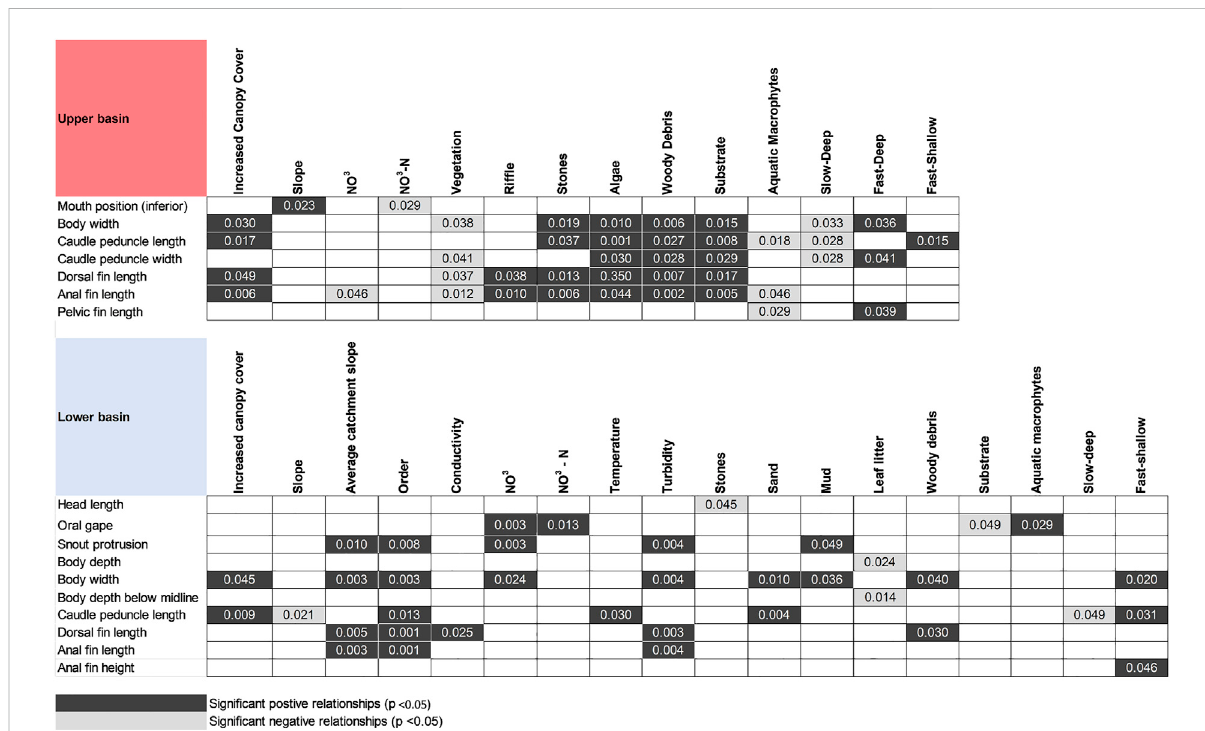
FIGURE 7 Results of the fourth-corner analyses for the upper and lower basin dataset. Black signi fi es a signi fi cant positive relationship (Pearson ’ s correlation) between environmental variable and trait, and dark grey a signi fi cant negative